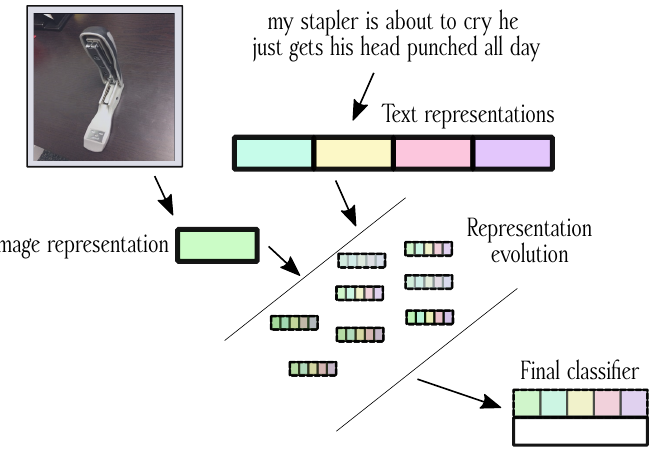
Figure 1. An overview of the proposed MuRE architecture. Different types of inputs (images, texts) are transformed into suitable representations (either embeddings or sparse matrices corresponding to, e.g., n-gram-based features). The representations are used to construct joint representation space that is iteratively re-weighted by evolution strategies. The final result is a re-weighted feature space alongside fine-tuned classifiers (hyperparameters are tuned for each obtained join